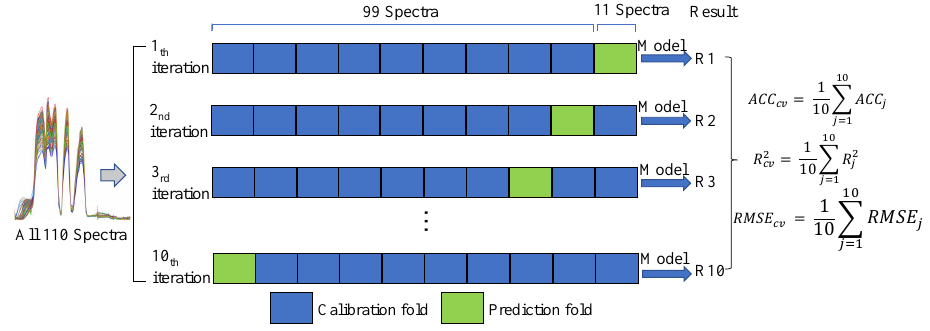
Figure 2. 10-fold crossvalidation of the Vis-NIR spectra